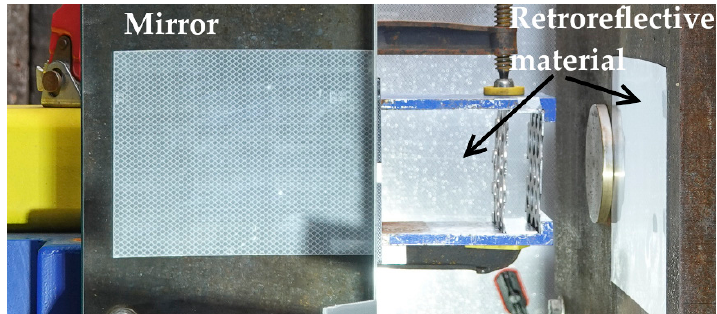
Figure 4. View of the EDST end showing the panel in the background, the piece of retroreflective material plastered on the wall and the 45-degree inclined mirror.